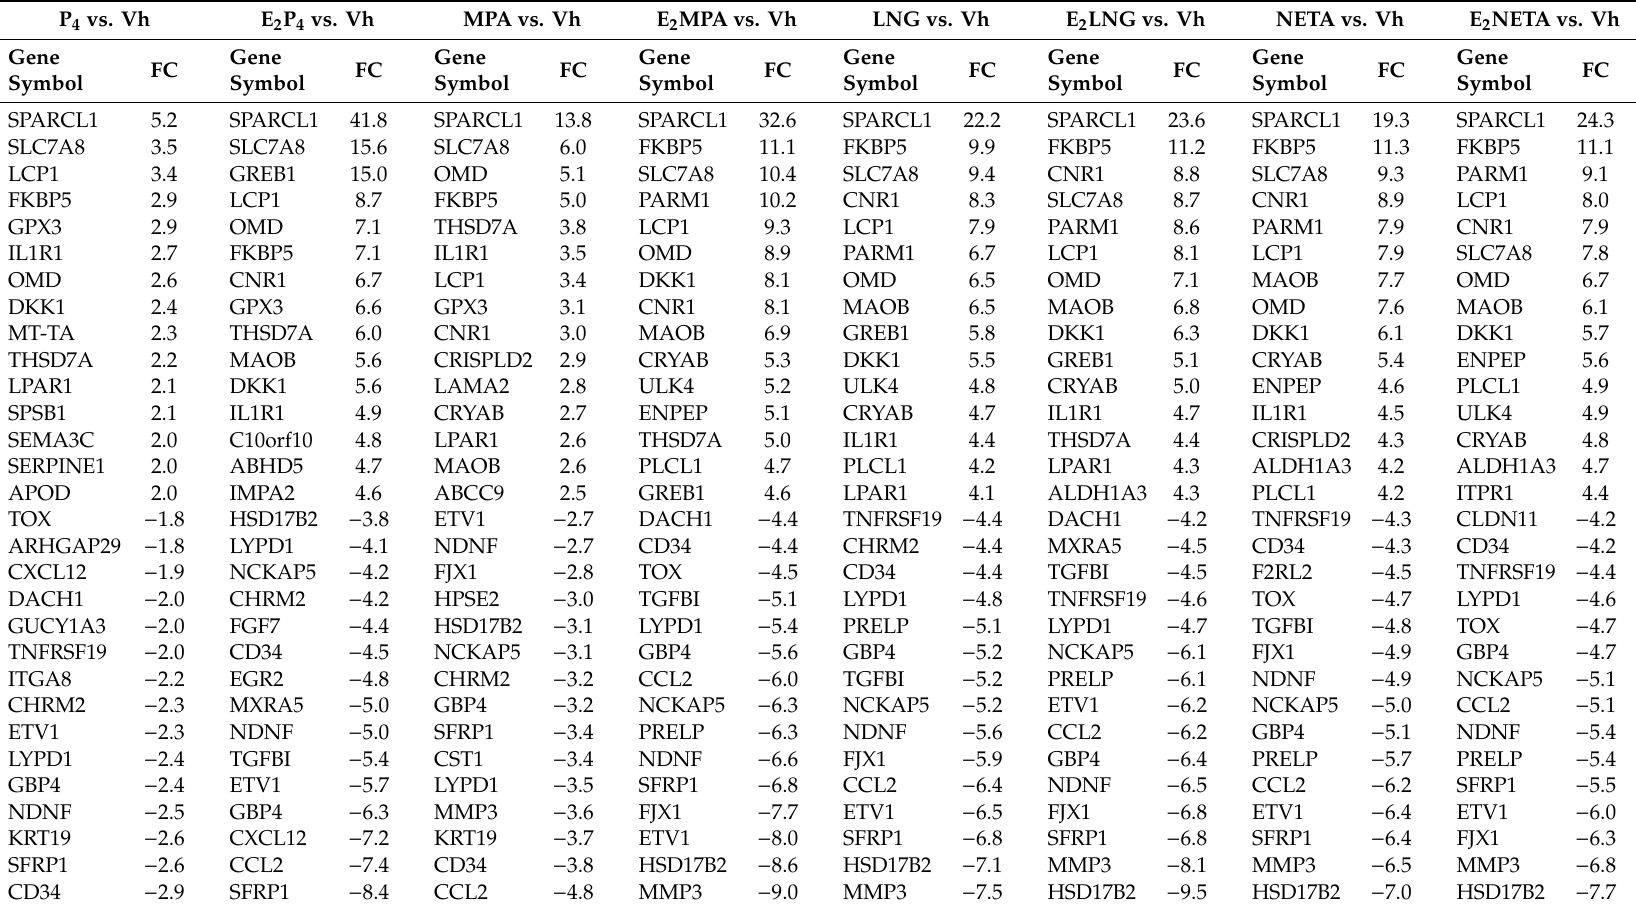
Table 2. Select di ff erentially expressed transcripts and genes in each progestin vs. vehicle without and with